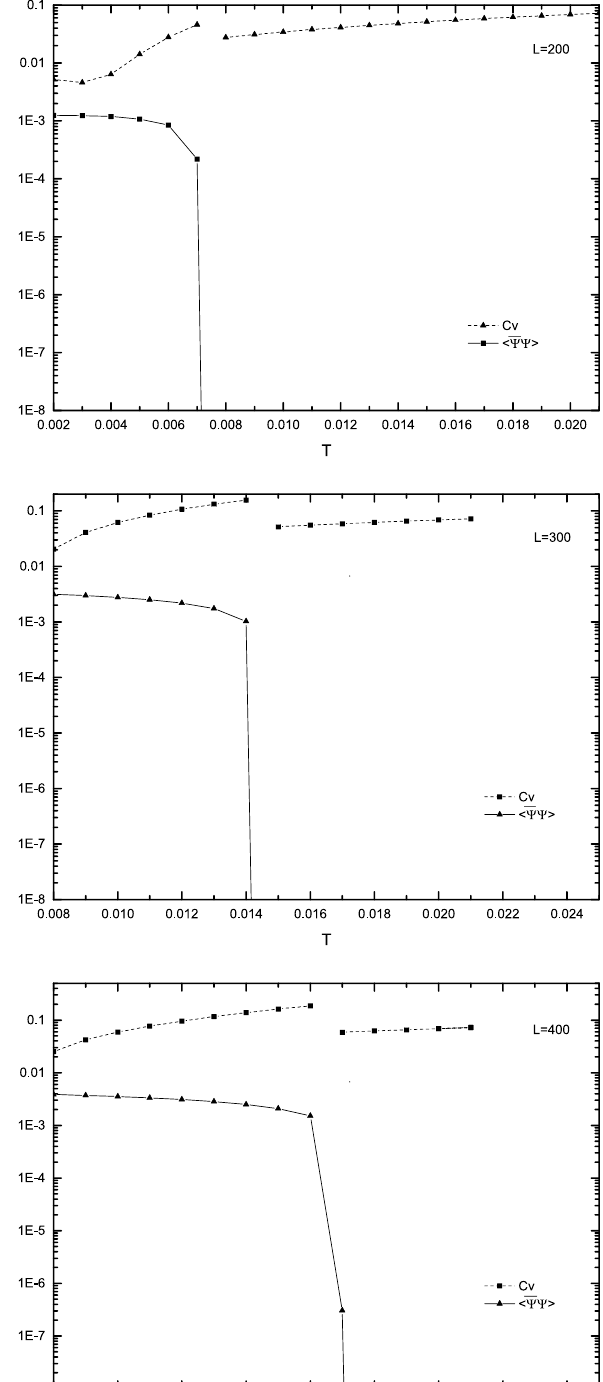
Fig. 6 The behavior of special heat with several volume size in mass- less QED 3